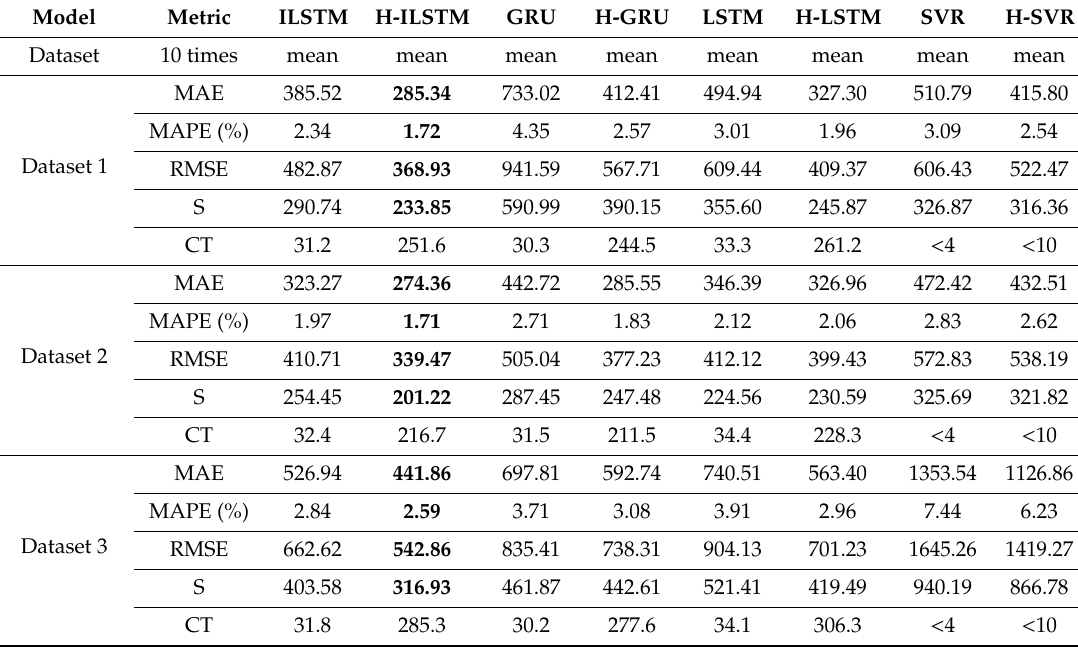
Table 12. The three-step prediction result of the load. (The bold characters in the table represent the best predictions among the eight